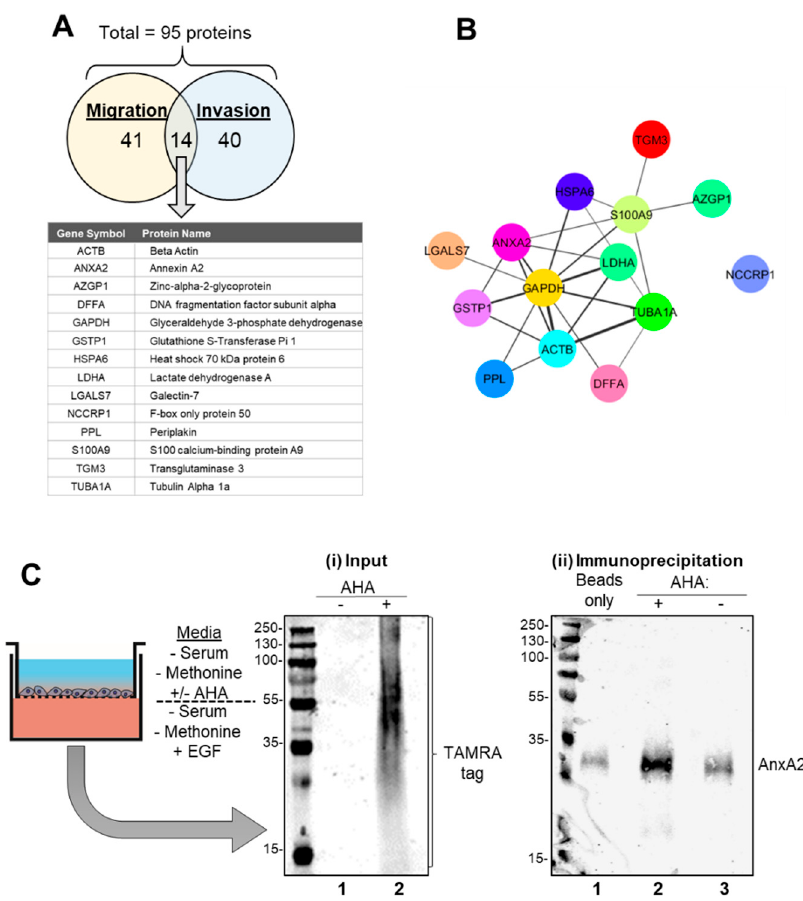
Figure 2. Annexin A2 is newly synthesized during the EGF stimulated migration and invasion of MDA-MB-231 cells. ( A ) 95 proteins in total were identified following mass spectrometry analysis and MASCOT peptide identification. Of these, 41 were found in the migration experiment only, 40 were found in the invasion experiment only and 14 were found to be common to both, listed here. ( B ) Protein-protein interactions between the 14 proteins found to be common to both the migration and invasion lists were assessed with String (http://string-db.org) [16] and visualized using the StringApp in Cytoscape set at 0.2 confidence level [17]. Edge line thickness denotes the confidence of association between protein nodes. ( C ) ( i ) Input: Western blot analysis of Click-It reaction lysate shows successful incorporation of the TAMRA tag into newly synthesized proteins when AHA was added. (Lane 1: